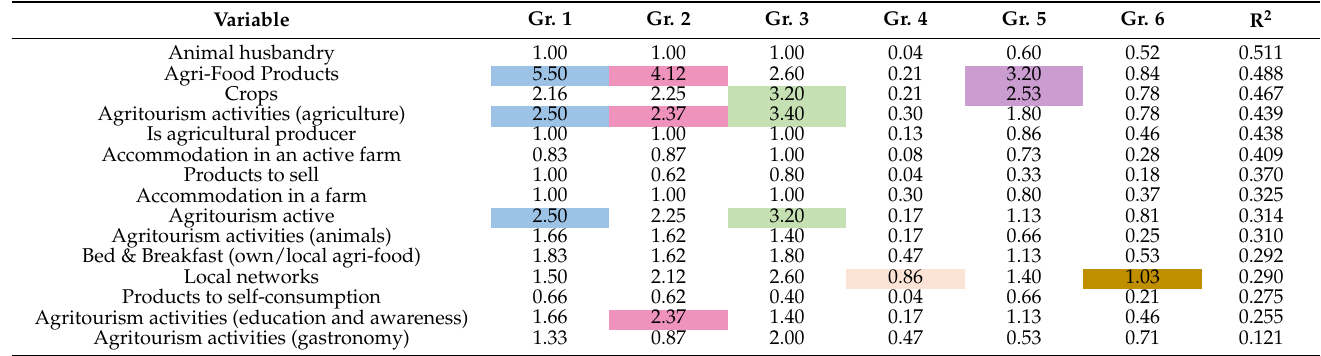
Table 8. Variable contribution (mean value) by groups obtained via Delaunay Triangulation. Variable Gr.